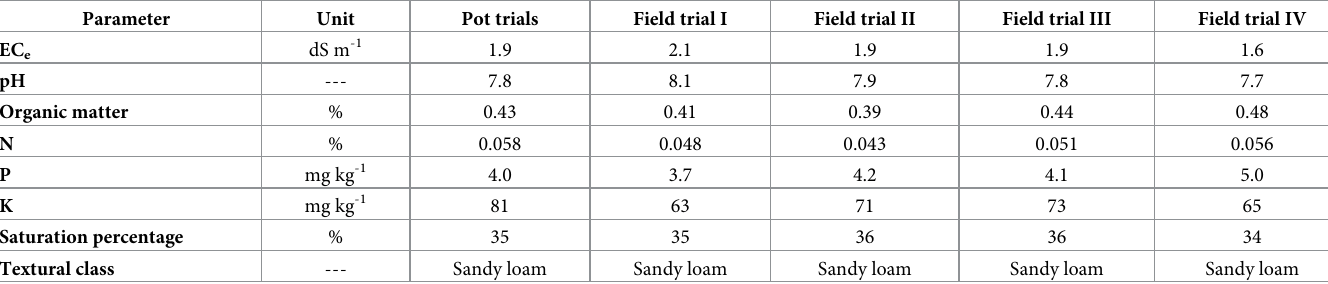
Table 6. Physico-chemical characteristics of the soil prior to sowing.